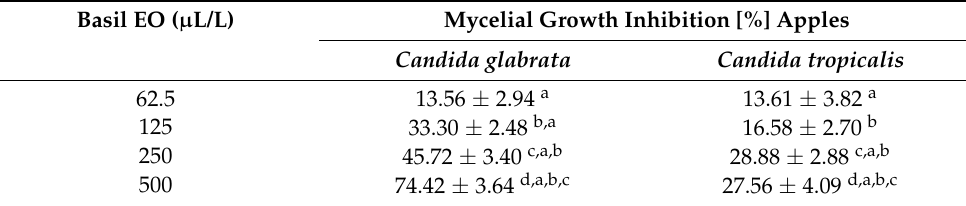
Means ± standard deviation ( n = 3). Individual letters (a–d) in upper case indicate the statistical difference at p ≤